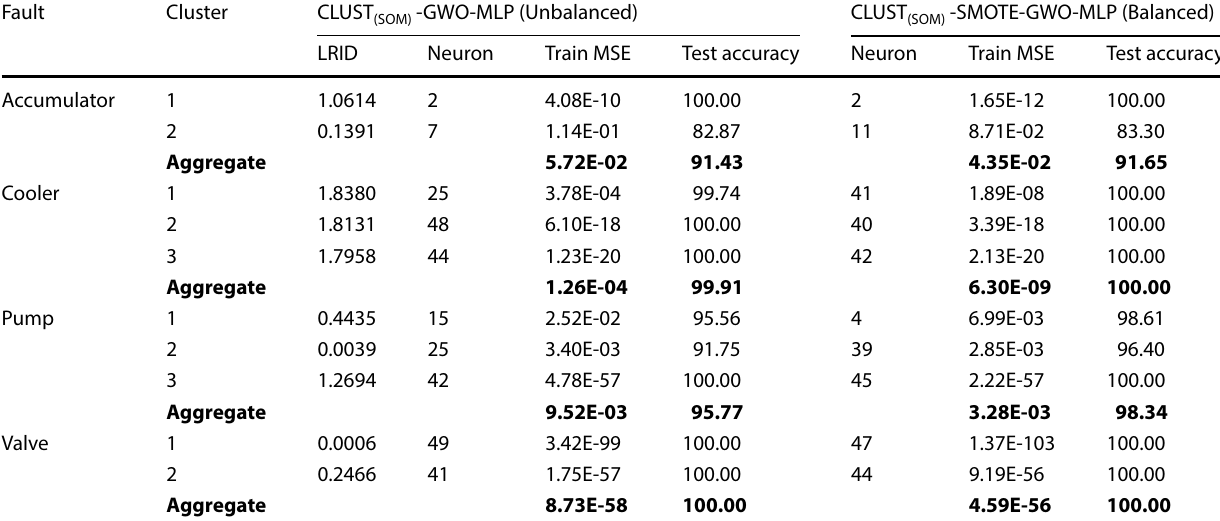
Table 7 Fault classification based on CLUST (SOM) -GWO-MLP and CLUST (SOM) -SMOTE-GWO-MLP